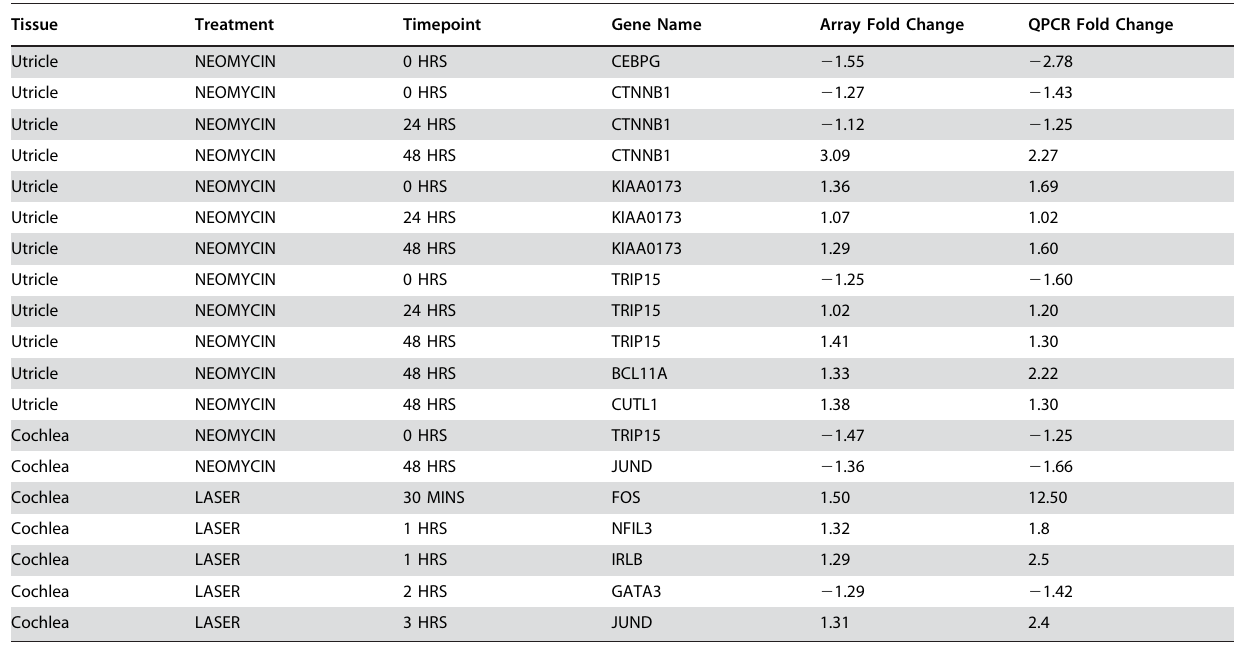
Table 1. QPCR validation of microarray fold-changes. .. ... .... ... ... .... ... ... .... ... ... .... ... ... .... ... ... .... ... ... .... ... ... .... ... ... .... ... ... .... ... ... .... ... ... .... ... ... .... ... ... .... ... ... .